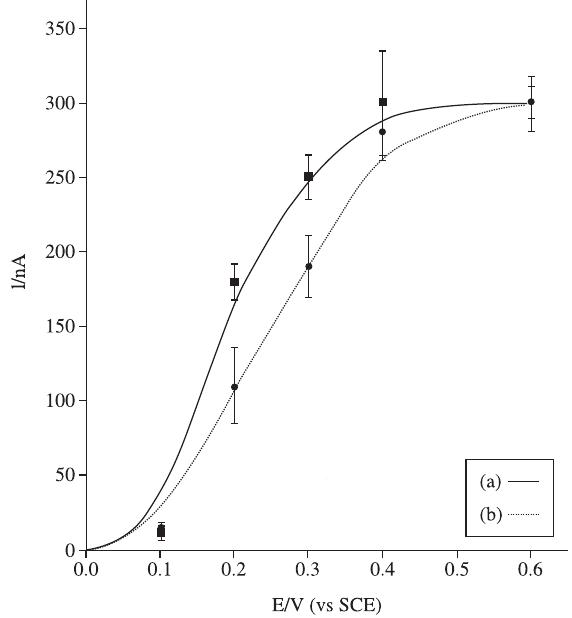
Figure 4. Current-time curve during the PGLD (a) and CHD (b) biosensors at 300 mV, pH 7.0 (NaPBS) and 37 °C in glucose solution of 20 mM. The error bars represent the standard deviations between five electrodes.